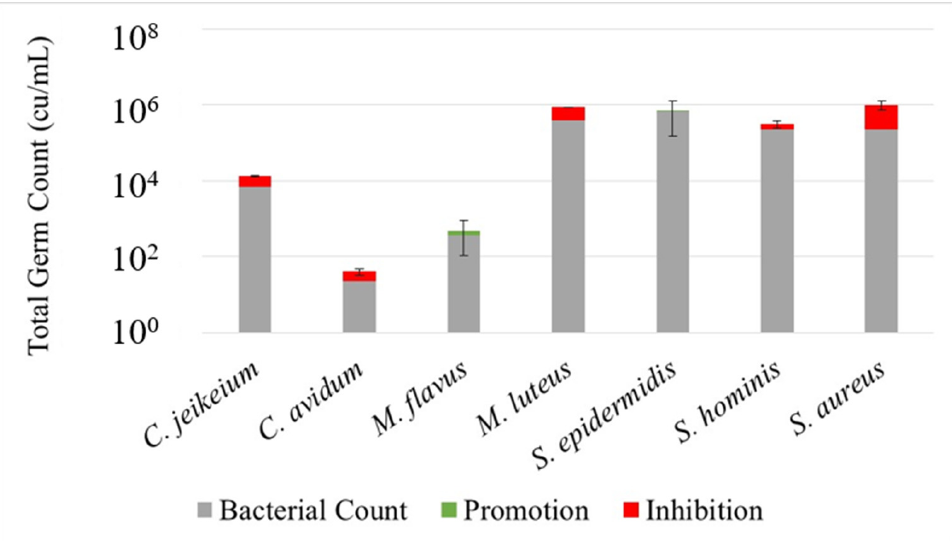
Figure 5. Total germ count of C. jeikeium , C. avidum , M. flavus , M. luteus , S. epidermidis , S. hominis and S. aureus with the indication of promotion and inhibition of 10 μ L serum with 0.5% active 2. Grey bars represent the bacterial count of the untreated control, while red or green areas indicate inhibition or promotion by the treatment with serum with 0.5% active 2, respectively. All measurements have been performed in duplicates. Except for M. luteus (indicated by an asterisk), no significant differences could be detected using Student’s t -test ( p < 0.1).